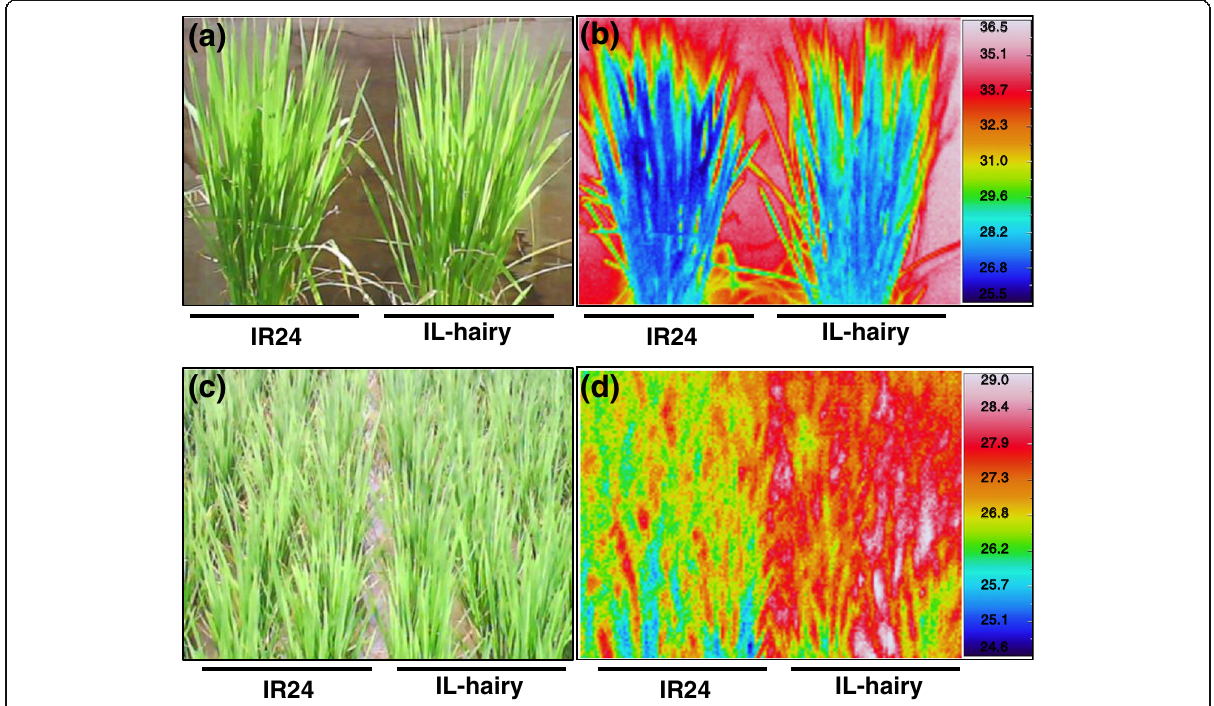
Fig. 3 Visible and thermal images of IR24 and IL-hairy grown in pots ( a , b ) and in the field ( c , d ) at booting